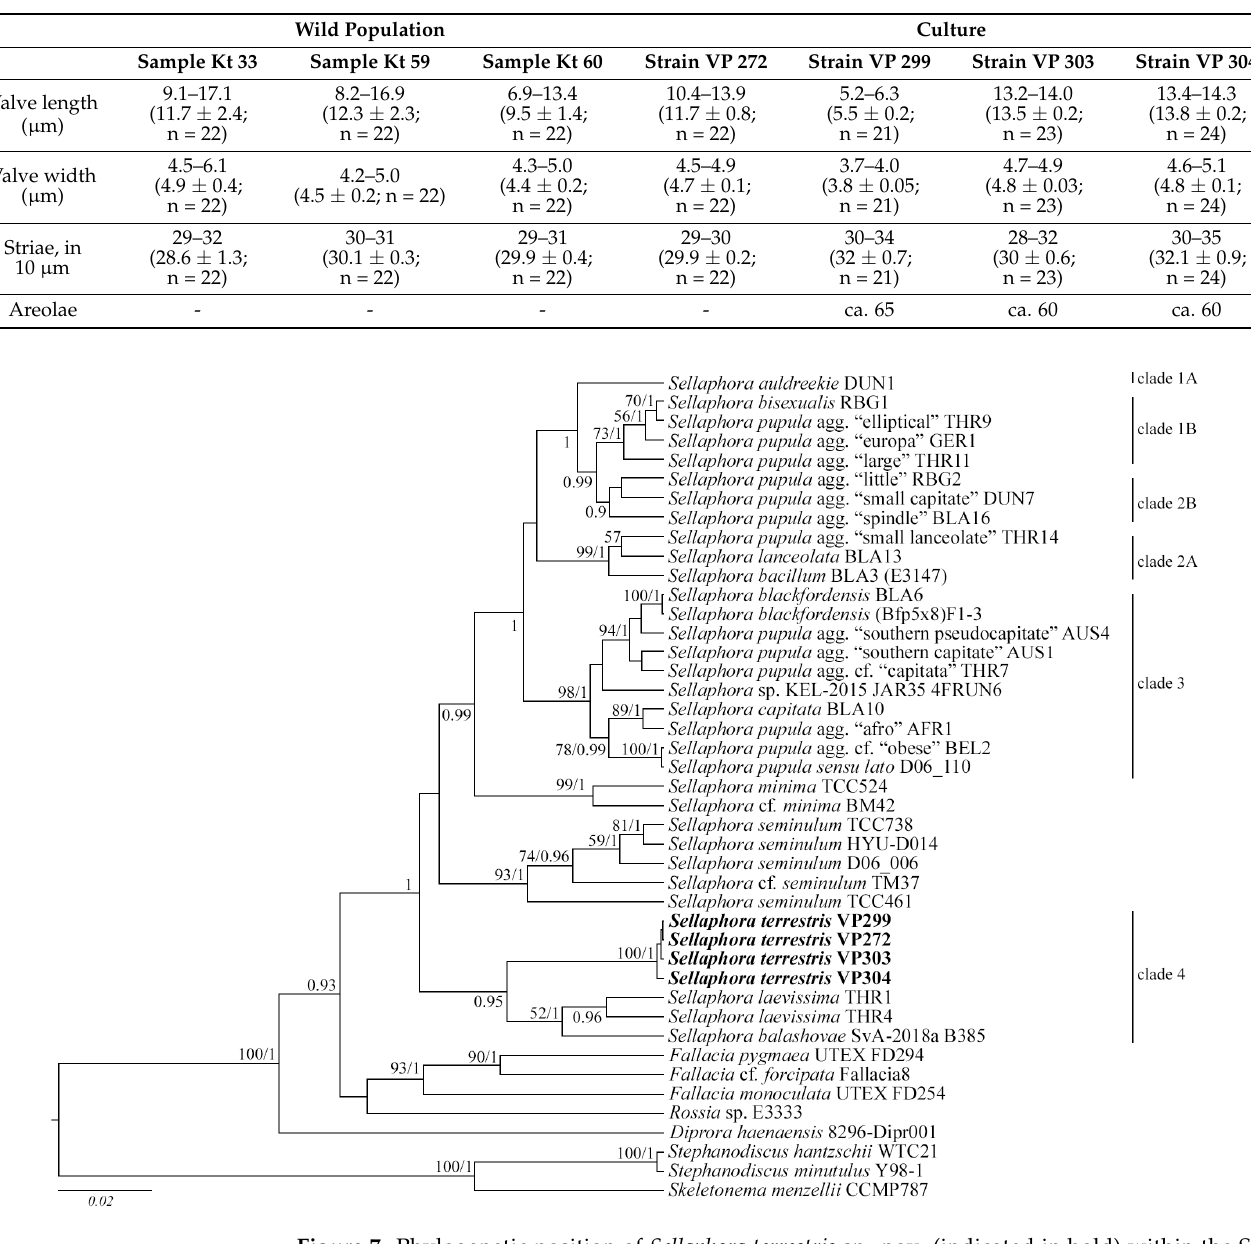
Figure 7. Phylogenetic position of Sellaphora terrestris sp. nov. (indicated in bold) within the Sellaphoraceae based on Bayesian inference for a concatenated alignment of 43 partial rbc L and partial 18S rDNA sequences. The total length of the alignment was 1361 characters. Values above the horizontal lines are bootstrap support from ML analyses (<50 are not shown); values below the horizontal lines (or to the right of the slash) are Bayesian posterior probabilities (<0.9 are not shown). Strain numbers (if available) are indicated for all sequences. Clades indicated sensu Evans et al. [9], and Mann and Poulí č ková [12] are at the right.